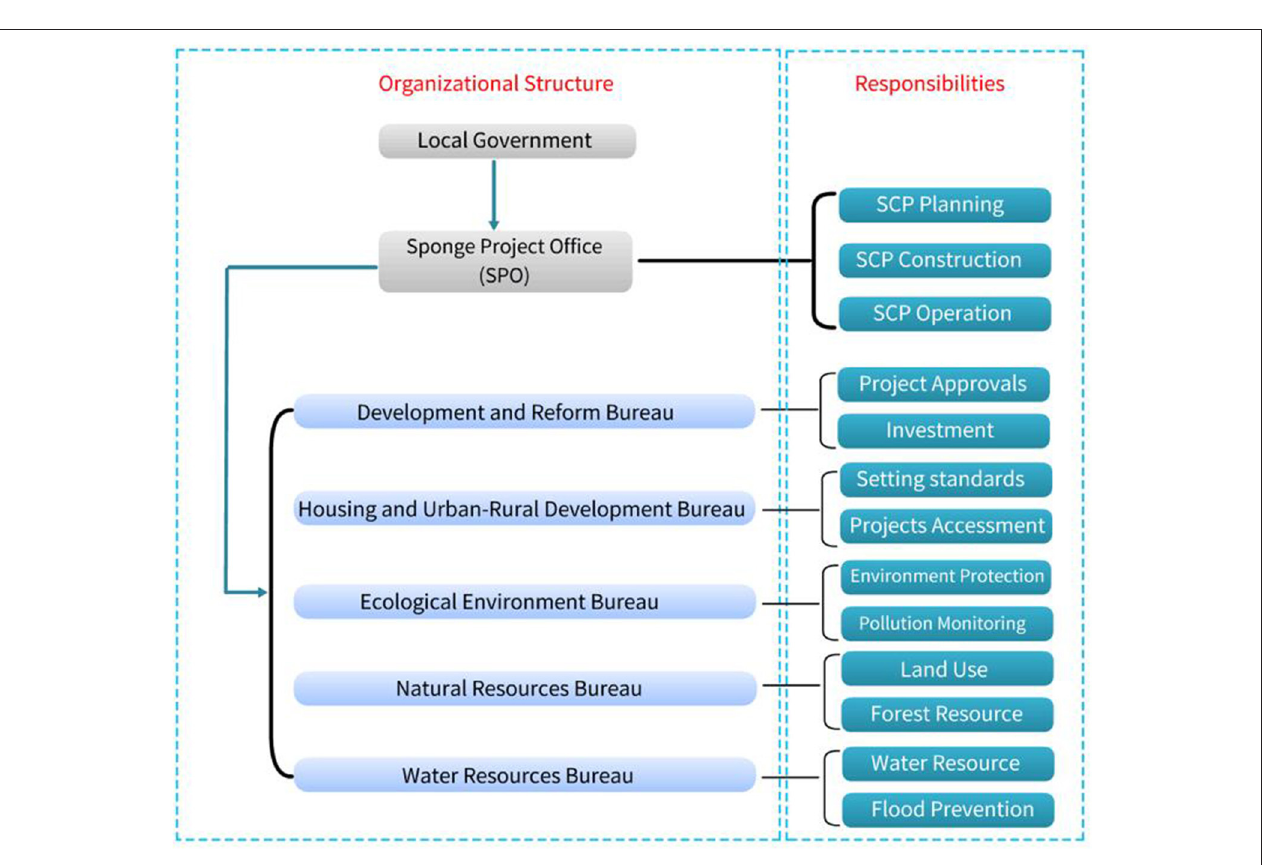
FIGURE 9 | Sponge Project Office authorized by the local district government (Source: